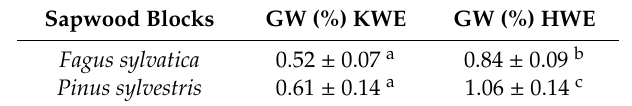
Table 2. Gained weight (GW, %) for impregnated beech and Scots pine sapwood.